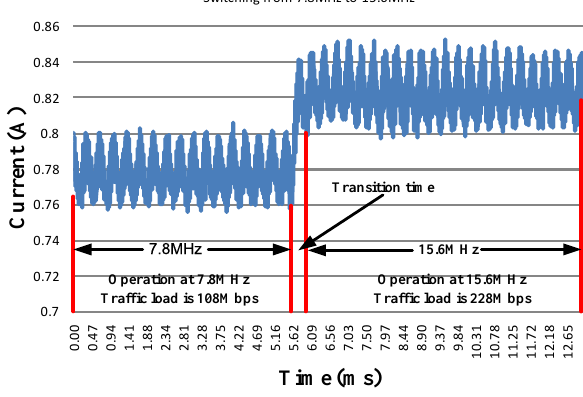
Figure 18. An example of the transition time